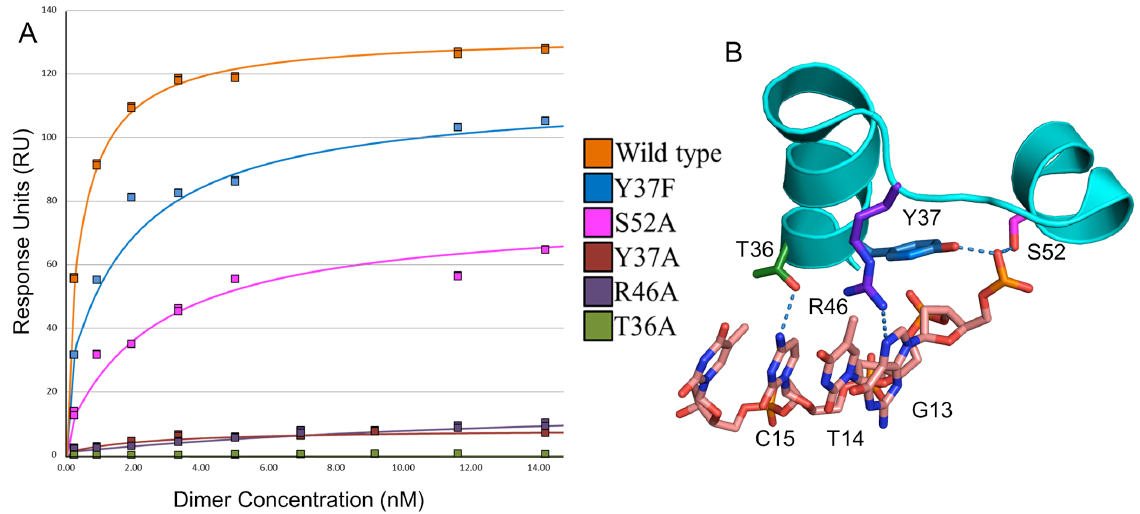
Figure 2. Binding analysis and location of mutations. (A) DNA binding curves of C.Esp1396I mutant proteins binding to the O M operator site from SPR data. (B) The amino acid residues mutated in this study (T36, Y37, R46 and S52) showing their location at the DNA-protein interface. Image generated in PyMOL using the wild type C.Esp1396I-19O M co-crystal structure (3UFD).